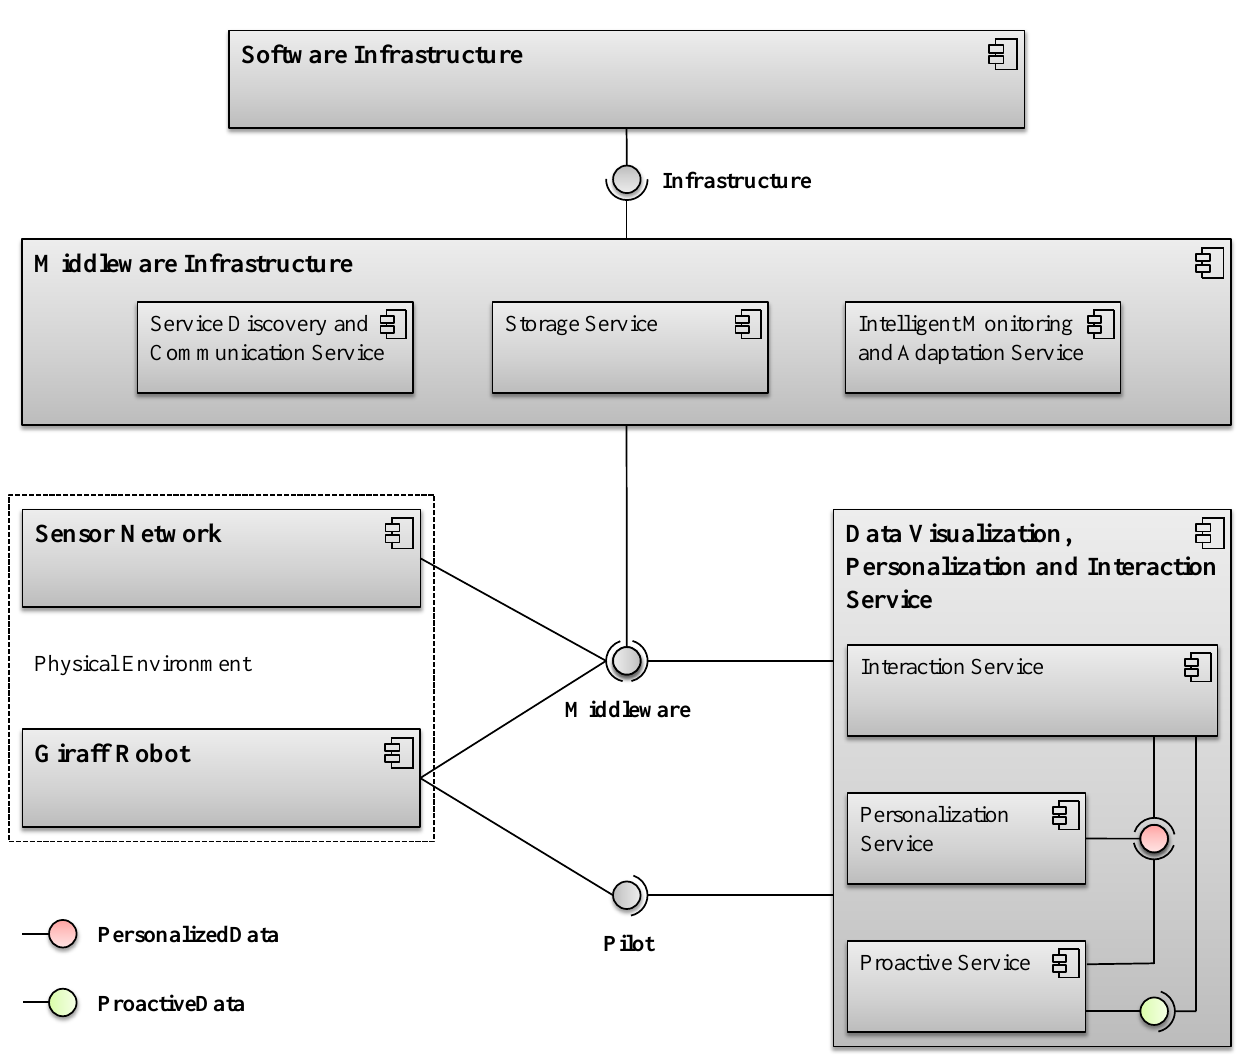
Figure 1. The GiraffPlus system